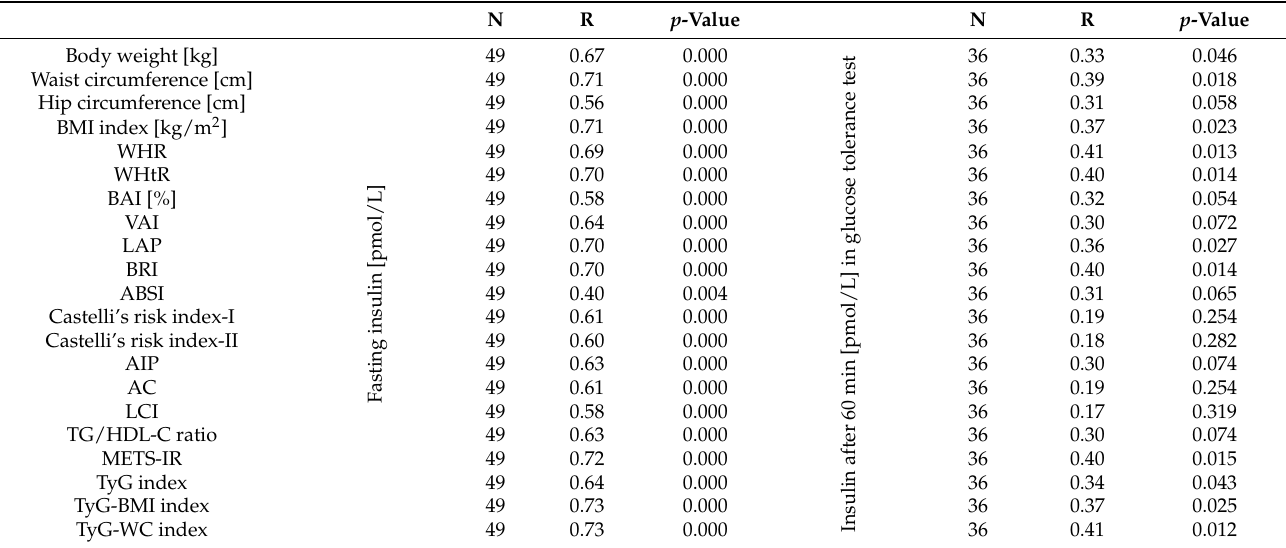
Table 3. Correlation between anthropometric parameters, atherogenic indices and insulin profile in the study group.